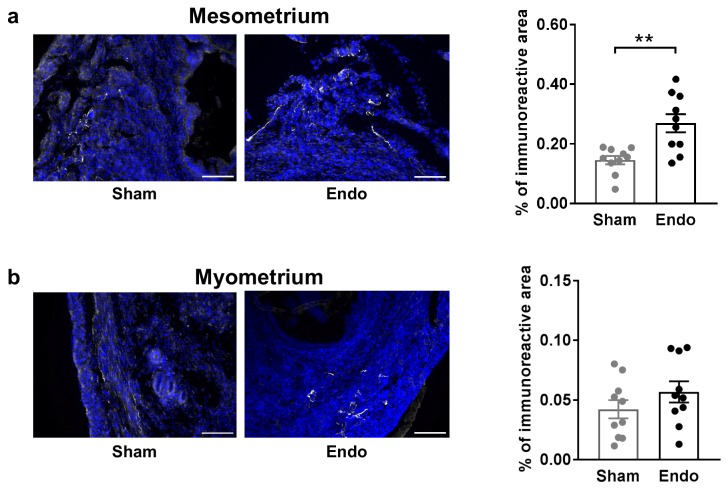
Density of beta-III tubulin-labeled fibers in uteri of endometriosis and sham mice.(a) The percentage of immunoreactive area of the mesometrial aspect of the uterus was higher in endometriosis mice. (b) The percentage of immunoreactive area of myometrium did not differ between groups. Blue is DAPI and white is β-III tubulin. Scale bar = 100 μm. Error bars are mean ± SEM. Student t-test. **p<0.01 vs sham. Endo, endometriosis.